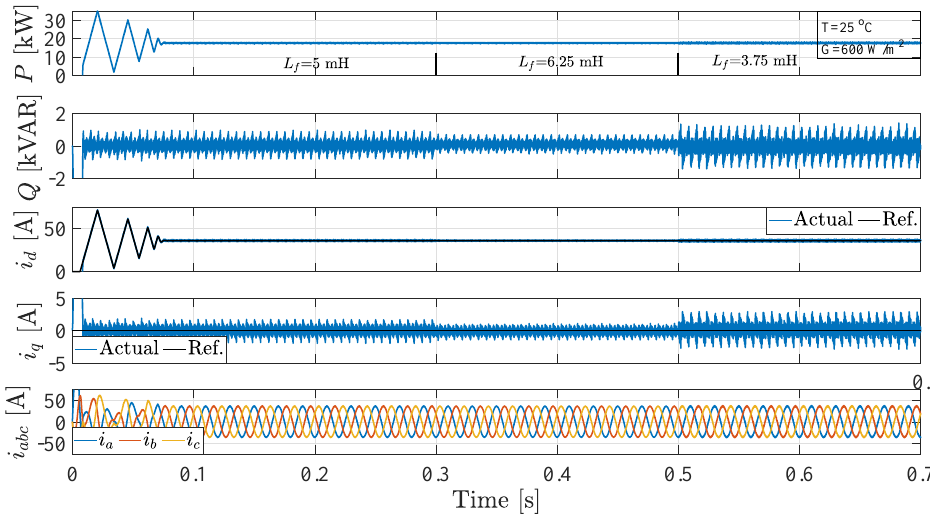
Figure 22. Grid-connected inverter behavior at filter inductance variation (from top): active power injected into the grid, reactive power, d -axis current, q -axis current, and the abc